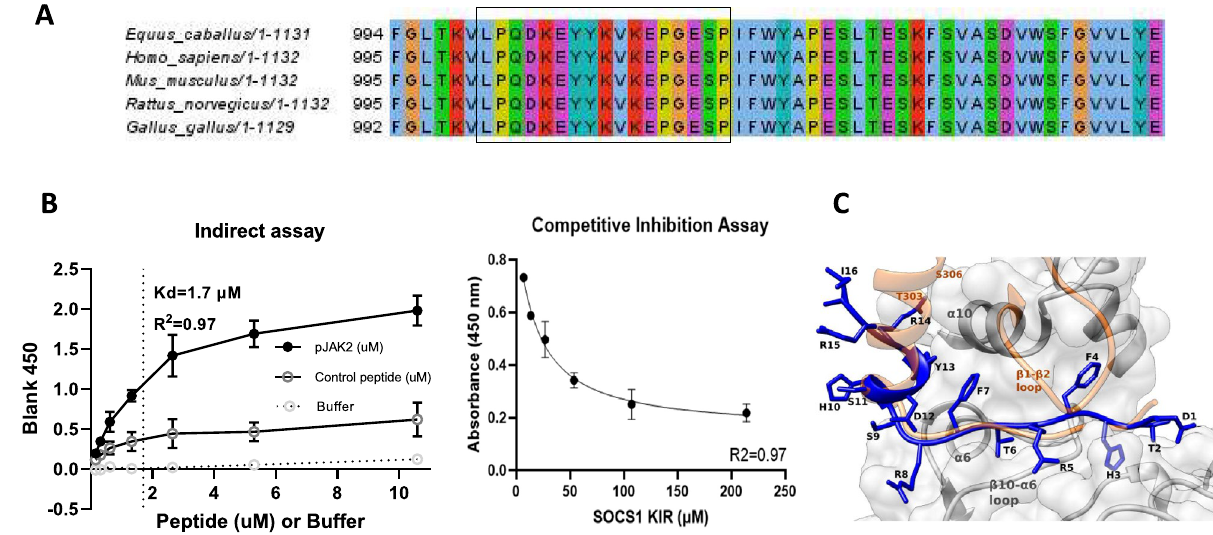
Figure 2. SOCS1-KIR Mimetic Peptide can Associate with Equine JAK2. ( A ) Graph showing direct binding of SOCS1 KIR mimetic peptide to biotinylated pJAK2 (1001–1013) peptide (n = 3). SOCS1 demonstrated a one site—specific binding relationship to pJAK2 (R 2 = 0.97). ( B ) Representative curve of competition assay of biotinylated pJAK2 preincubated with varying amounts of SOCS1 KIR mimetic peptide for 2 h time, followed by addition to 96 well plate pre-coated with SOCS1 KIR mimetic (n = 3). This representative sample had a semi-logarithmic fit (R2 = 0.97). ( C ) Computer model generated using MODELLER overlaying the SOCS1 KIR mimetic (Blue) and full-length horse SOCS1 (peach) interacting with horse among vertebrate species, particularly mammals, suggesting translatability of the SOCS1-KIR mimetic in the treatment of ERU. Endogenous SOCS1 binds to the activation loop of JAK2, inhibiting both autophosphorylation at tyrosine residue pY1007 and subsequent cellular programming that drives inflammation 37,38 . Given the homology of SOCS1-KIR mimetic to the corresponding region of equine SOCS1, we next assessed the conservation of Jak2 activation loop between putative horse, human, mouse, rat, and bird species. As can be seen in Fig. 2A the activation loop of Jak2, postulated to interact with SOCS1, is 100% conserved between the indicated species. To confirm previous publications demonstrating the binding of the SOCS1-KIR mimetic peptide to the autophosphorylation site of pJak2 (Jak2 1001–1013) 23,34 , direct and competitive in vitro binding assays were